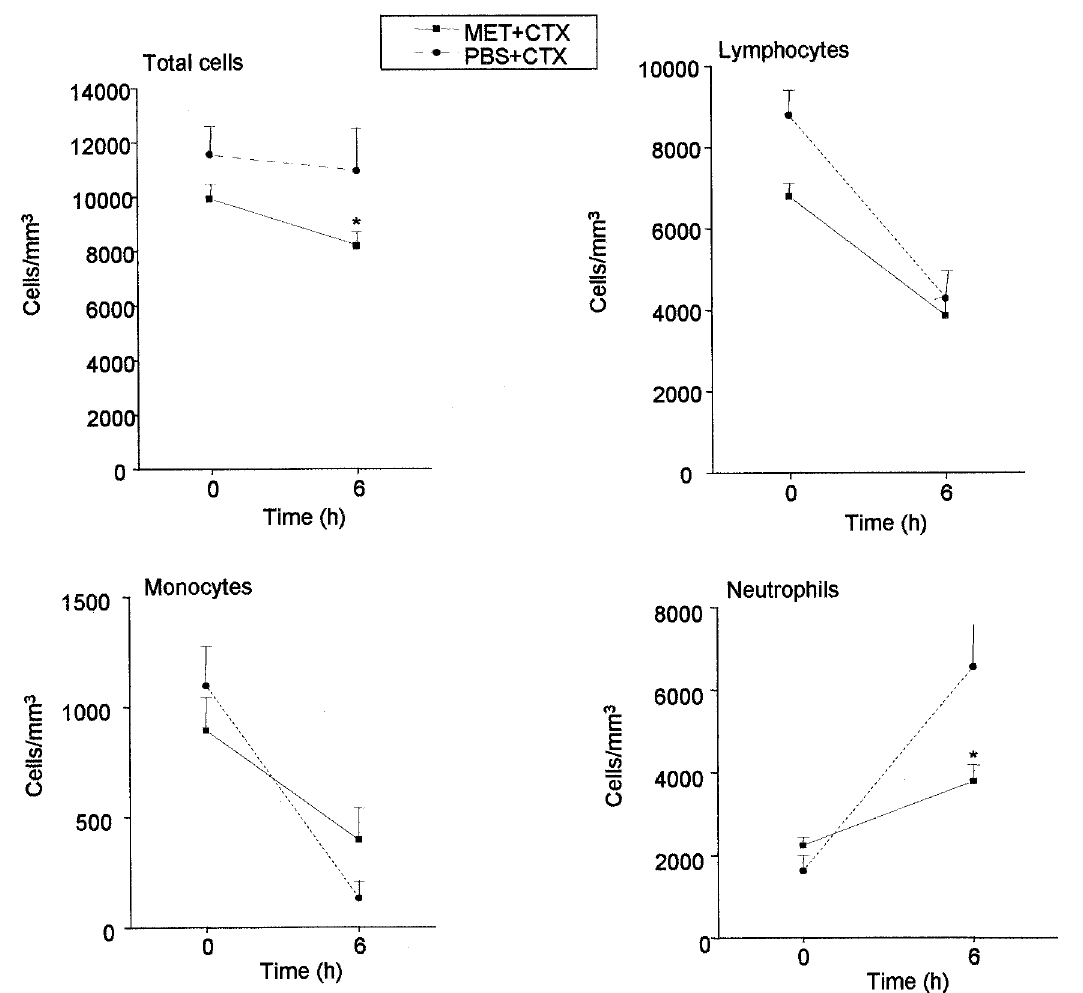
FIG. 6. Effect of metyrapone (MET) pre-treatment on leukocyte mobilisation alterations evoked by crotoxin (CTX). Animals were pre-treated with metyrapone (30mg/kg, intraperitoneally; every 12h, for 3 days) or equivalent volume of phosphate-buffered saline (PBS) and, 2h after the last administration, received CTX (5 m g/100 m l; subcutaneously). Before and 6h after CTX injection, blood was collected from the orbital plexus, and total leukocyte, lymphocyte, monocyte and neutrophil numbers were determined. Values represent the mean ± SEM of six animals in each group. * p < 0.05 in comparison with values obtained in control